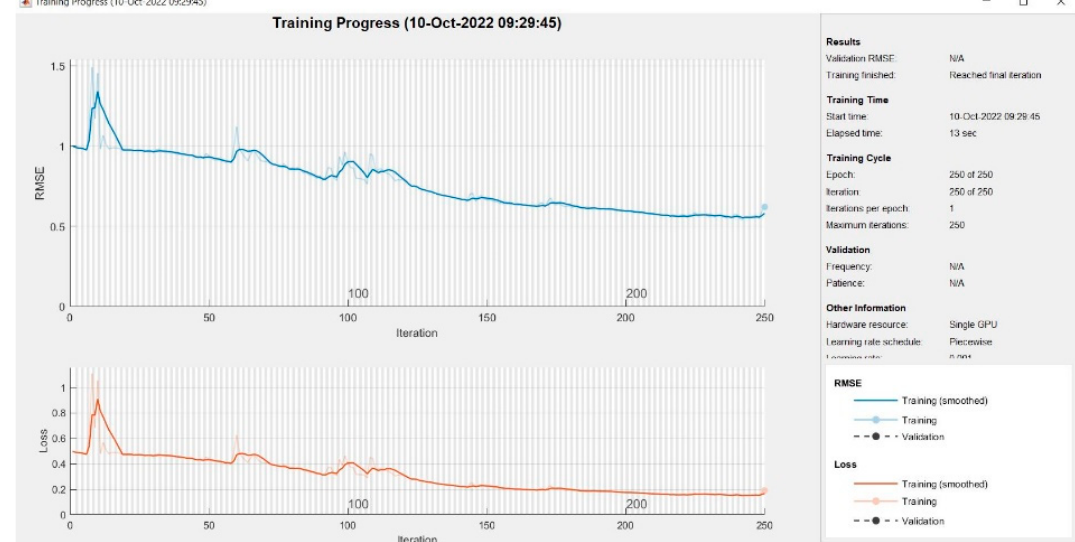
Figure 10. Training curve for the LSTM.